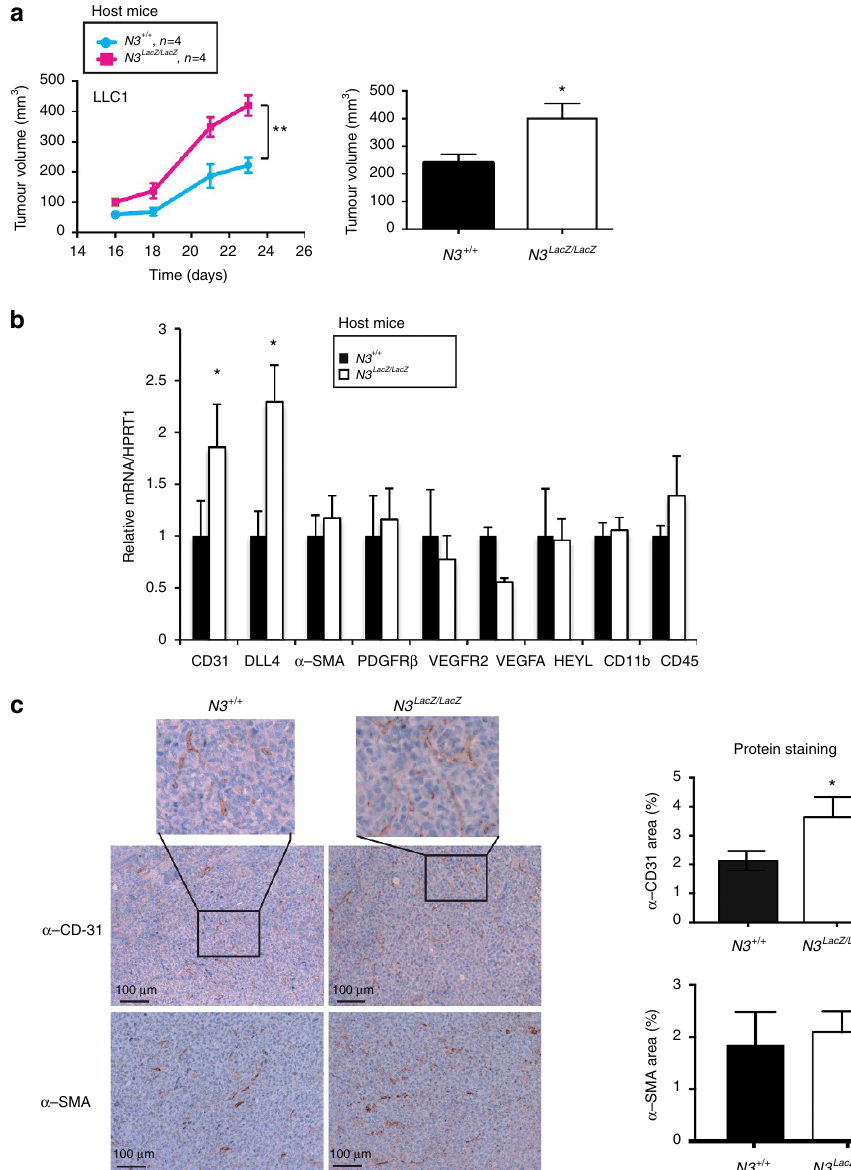
Figure 2 | Notch3 limits tumour growth and vascularization in vivo . ( a ) 5 (cid:2) 10 5 LLC1 cells were implanted into the left flank of wild-type C57Bl/6 mice ( N3 þ / þ , n ¼ 4) or of Notch3 LacZ homozygous Knock-in C57Bl/6 littermates ( N3 LacZ/LacZ , n ¼ 4). Tumour growth was monitored from day 16 until day 24 when mice were sacrificed. Two-way ANOVA was performed to assess time and genotype effect on tumour growth (Interaction: P ¼ 0,013; Time: P o 0,0001; Genotype: P ¼ 0,0015). ( b ) mRNA was extracted from tumours dissected after 14 days of growth from wild-type C57Bl/6 mice